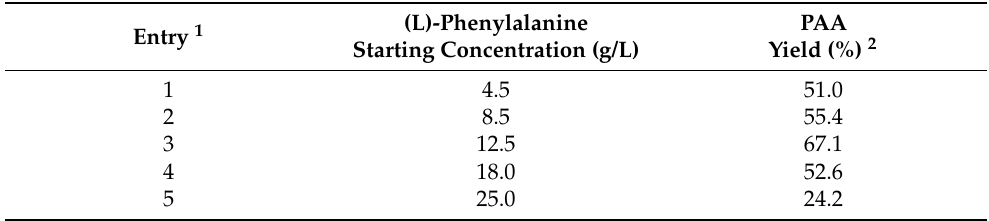
Table 3. Synthesis of phenylacetic acid by biotransformation of (L)-phenylalanine, at different concentrations, using Yarrowia lipolytica (DSM